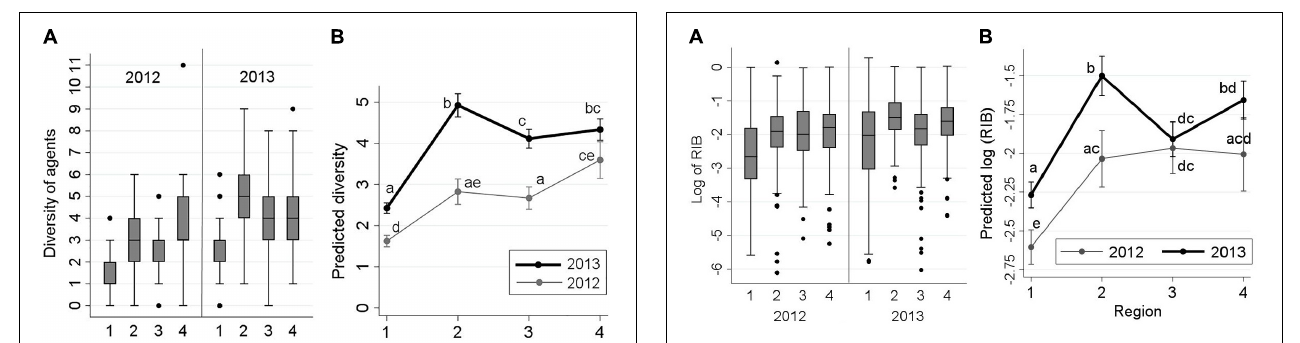
FIGURE 3 | Frequency distribution of log 10 -relative infection burden (RIB) of all detected infectious agents from 2,006 Fraser River juvenile Sockeye salmon by sampling region and year (left side: A ), and the interaction plot for the results of the linear regression model (right side: B ), indicating predicted log 10 -RIB ( Y -axis) for the fish by year and sampling region ( X -axis). Sampling regions: (1) Freshwater, (2) Strait of Georgia, (3) Discovery Islands, and (4) Johnstone Strait and north. Statistical comparisons among the predicted log 10 -RIB of these regions are presented by small letters on the graph. Small letters in (B) represent statistically significant differences (at α = 0.05) between the points (unique combinations of ‘region’ and ‘year’), obtained from pairwise comparisons using Bonferroni adjustments. Points that share, at least, a letter are not statistically different ( P > 0.05), and points with no letters in common have statistically significant differences in the predicted RIB ( P ≤